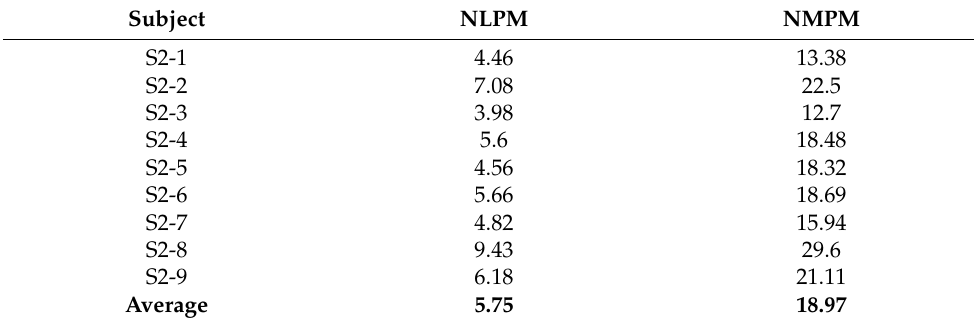
Table 2. Typing speed per